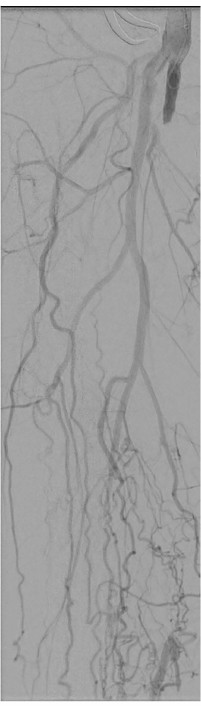
Figure 1. Overview of the baseline angiography of the left superficial femoral artery (SFA) showing that the SFA is largely occluded.